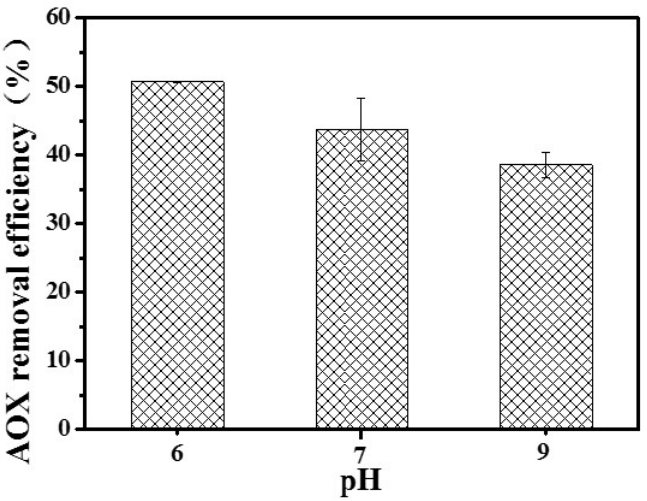
Figure 3. The effect of initial pH on the removal efficiency of AOX (Pd/Fe powder = 10 g/L, Pd loading = 0.05 wt %; reaction time was 15 days).